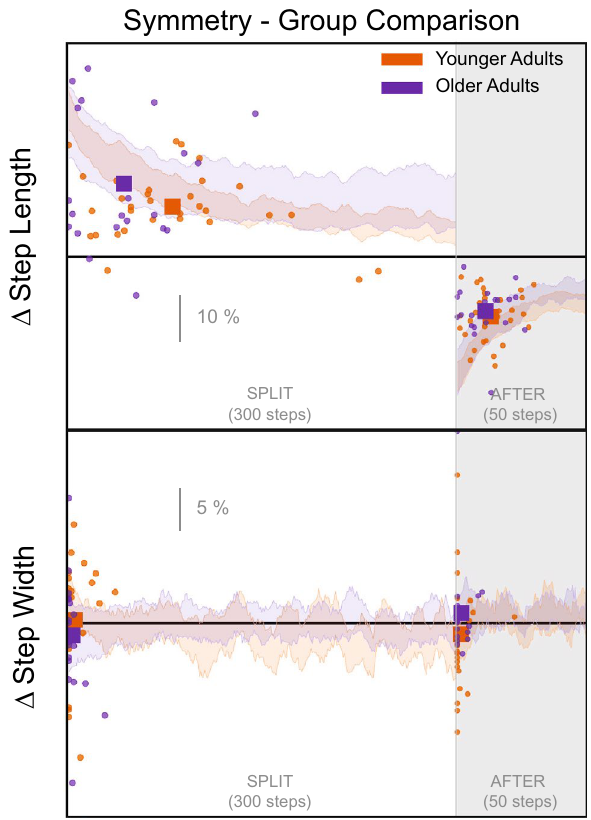
Figure 4. Spatial Gait Parameters Steps To Plateau graphs for younger (orange) and older (purple) adults for split and after conditions. The small circles indicate single subject steps to plateau and the larger squares indicate the group average. The shaded area represents the 95% confidence interval for the group average symmetry. The thick black horizontal line indicates perfect symmetry.